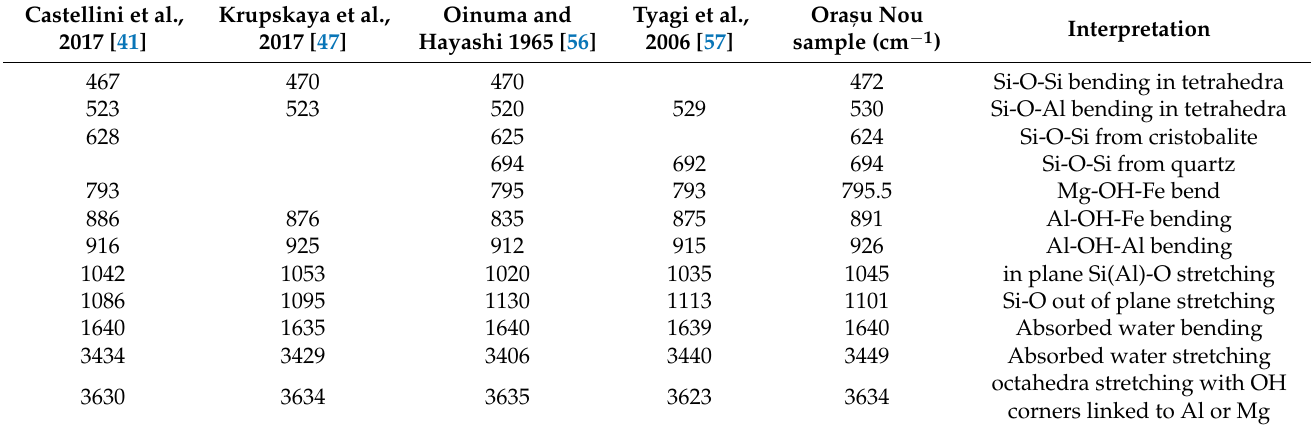
Figure 11. FTIR transmission spectra for the white nano-/microstructured Ora ș u Nou-montmorillo- FTIR transmission spectra for the white nano-/microstructured Oras nite separate. montmorillonite separate. Table 5. Comparative FTIR bands of the Ora ș u Nou bentonite with bentonites from scientific data base. Table 5. Comparative FTIR bands of the Oras u Nou bentonite with bentonites from scientific data base. , Castellini et Castellini et al.